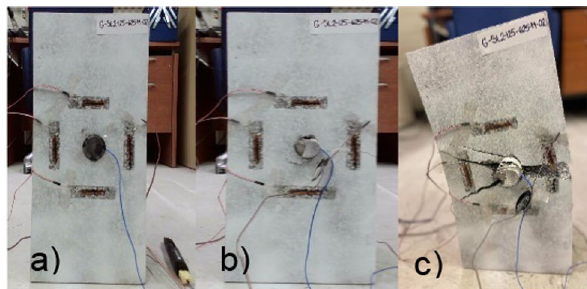
Fig. 10 G-SL2-125-625-M-02 a At time t